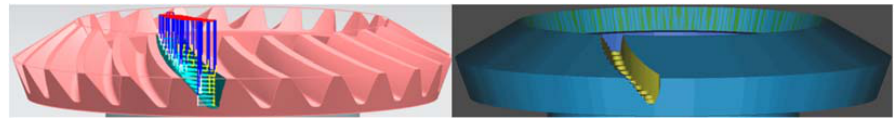
Figure 10. R ‐ V roughing strategy.